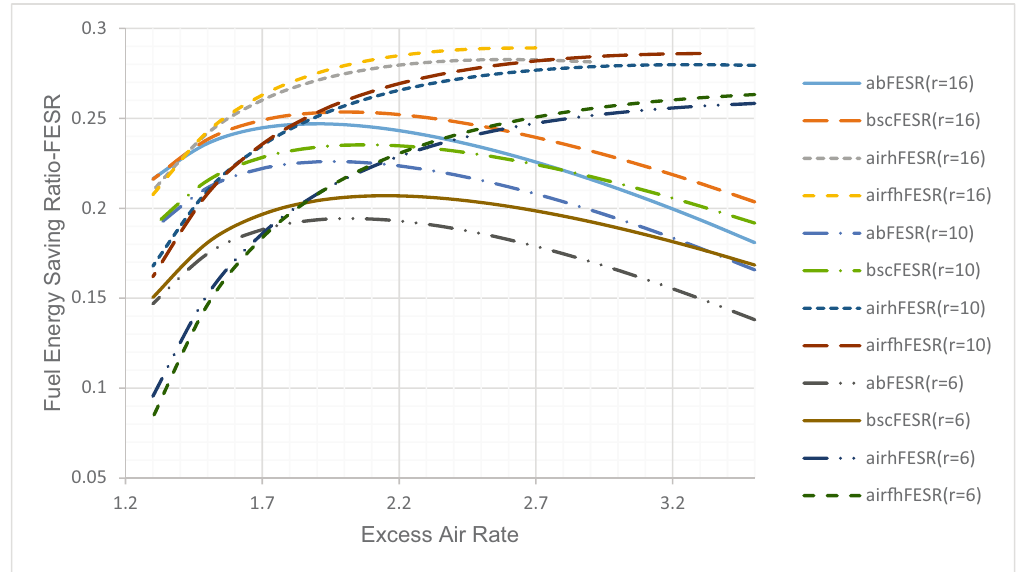
Figure 11: Variation of FESR with excess air coe ffi cient at di ff erent compressor compression ratios for basic ( bsc ) , absorption cooling ( ab ) , air ( airh ) , and air fuel ( airfh ) heating cogeneration cycles ( m fuel = 1.64 kg/h, η isC = η isT = 0.86, r = 10, T recout = 850 K, T steam = 485.57 K, and T = 426 K ) Exh